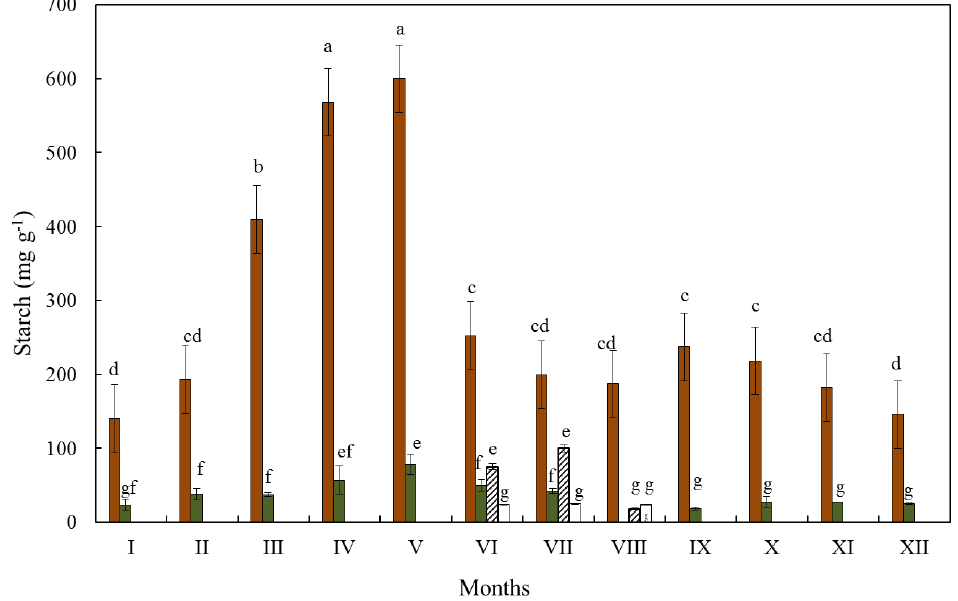
Figure 2. Starch content in bulbs (brown bars), expanded leaves (green bars), scapes (dashed bars), and petals (white bars) of Pancratium maritimum , from January (I) to December (XII). Each column denotes means of five replicates ± Standard Error; Standard Errors smaller than the line thickness of the columns are not shown. Significant differences ( p ≤ 0.05) of mean values are presented by different lowercase letters (a–g) on bars.